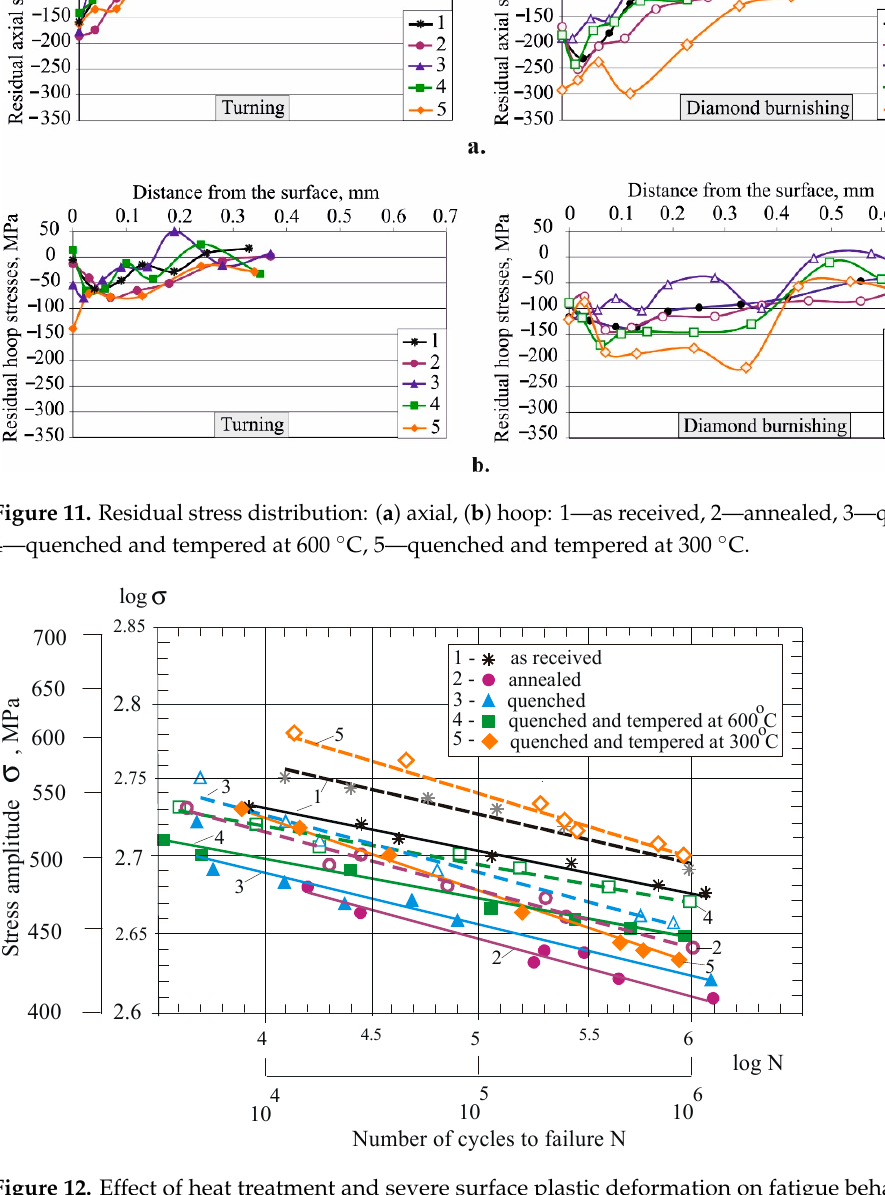
Figure 13. Dependence of fatigue strength on yield limit at different fatigue life: 1—as received, 2— annealed, 3—quenched, 4—quenched and tempered at 600 °C, 5—quenched and tempered at 300 °C. Figure 14 illustrates fatigue strength improvement by DB for low-cycle and mega- cycle fatigue, according to the number of cycles to failure for all five groups. Except for group 4, the HT increases the benefit of DB for increasing fatigue strength. Group 5 shows the greatest improvement. The main reason is the introduced useful residual hoop and axial stresses, which have the largest absolute value and maximum depth for group 5.